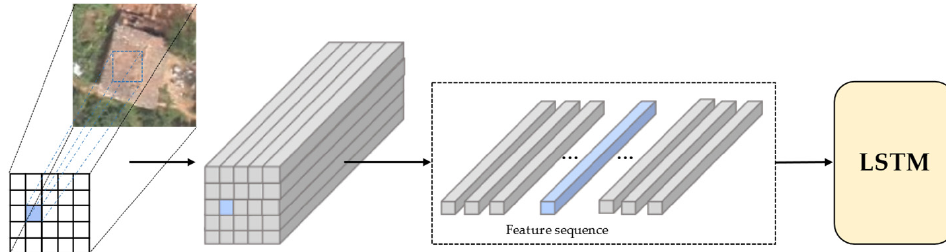
Figure 3. Feature sequence generation.